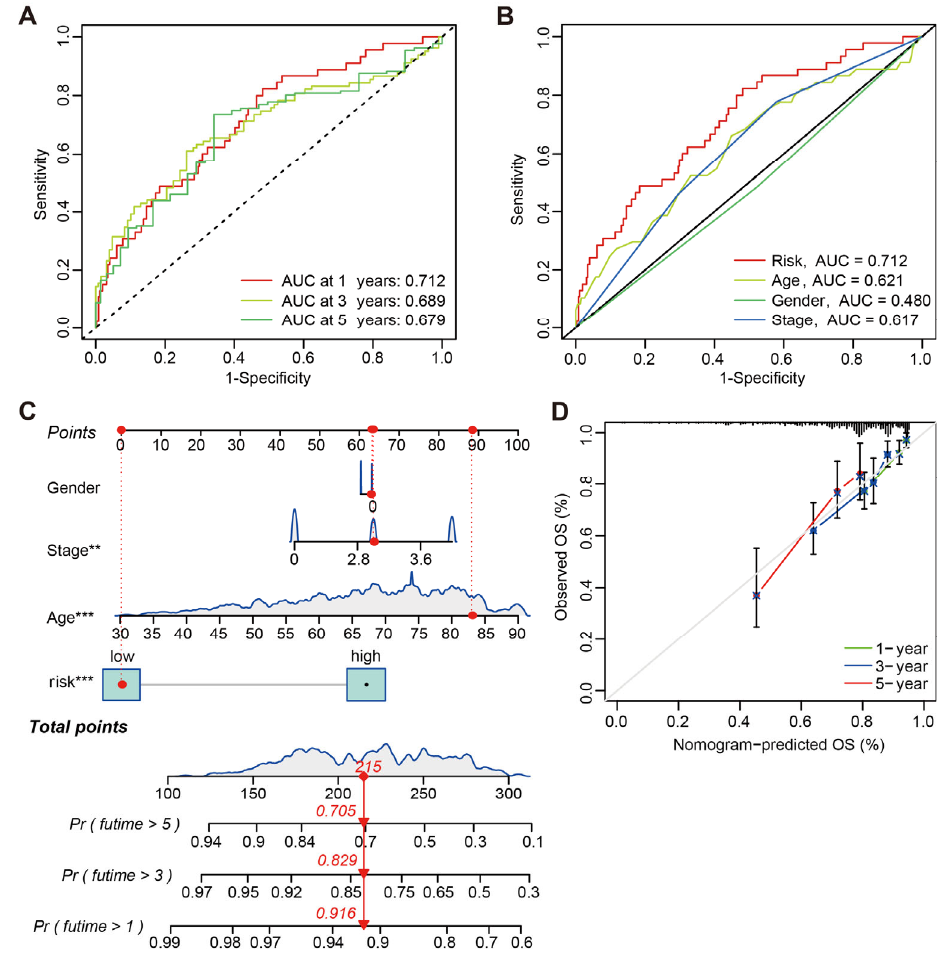
Figure 5. Prognostic prediction efficacy of the CRLs ‐ based risk score model. ( A ) ROC curve analysis result of the CRLs ‐ risk score. ( B ) ROC curve of the CRLs ‐ risk score and clinical characteristics for prognostic prediction power in CC patients. ( C ) Prognostic nomogram based on CRLs ‐ risk score and clinical characteristics to predict survival rates of CC patients (** p < 0.01 and *** p < 0.001). ( D ) Calibration curves of nomogram between the predicted and observed survival rates in CC patients.